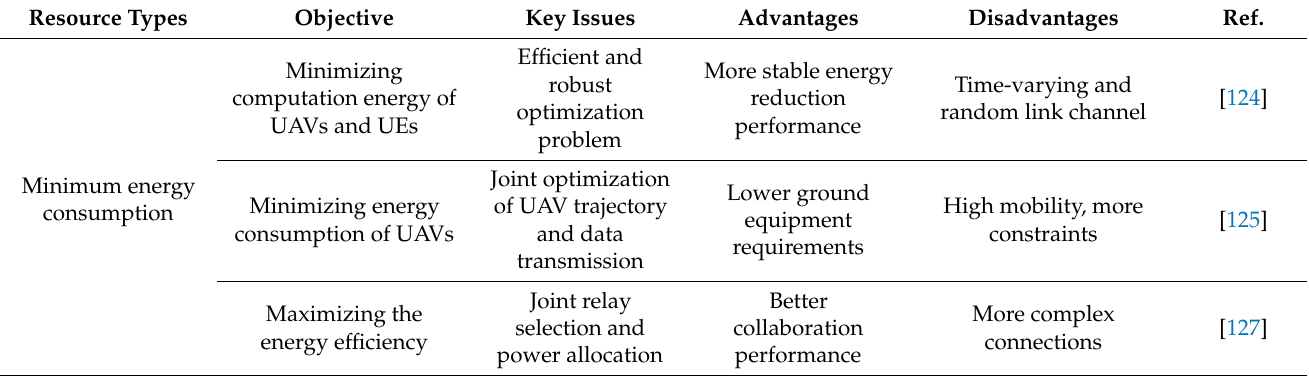
Table 3. Summary of related works on SAGIN